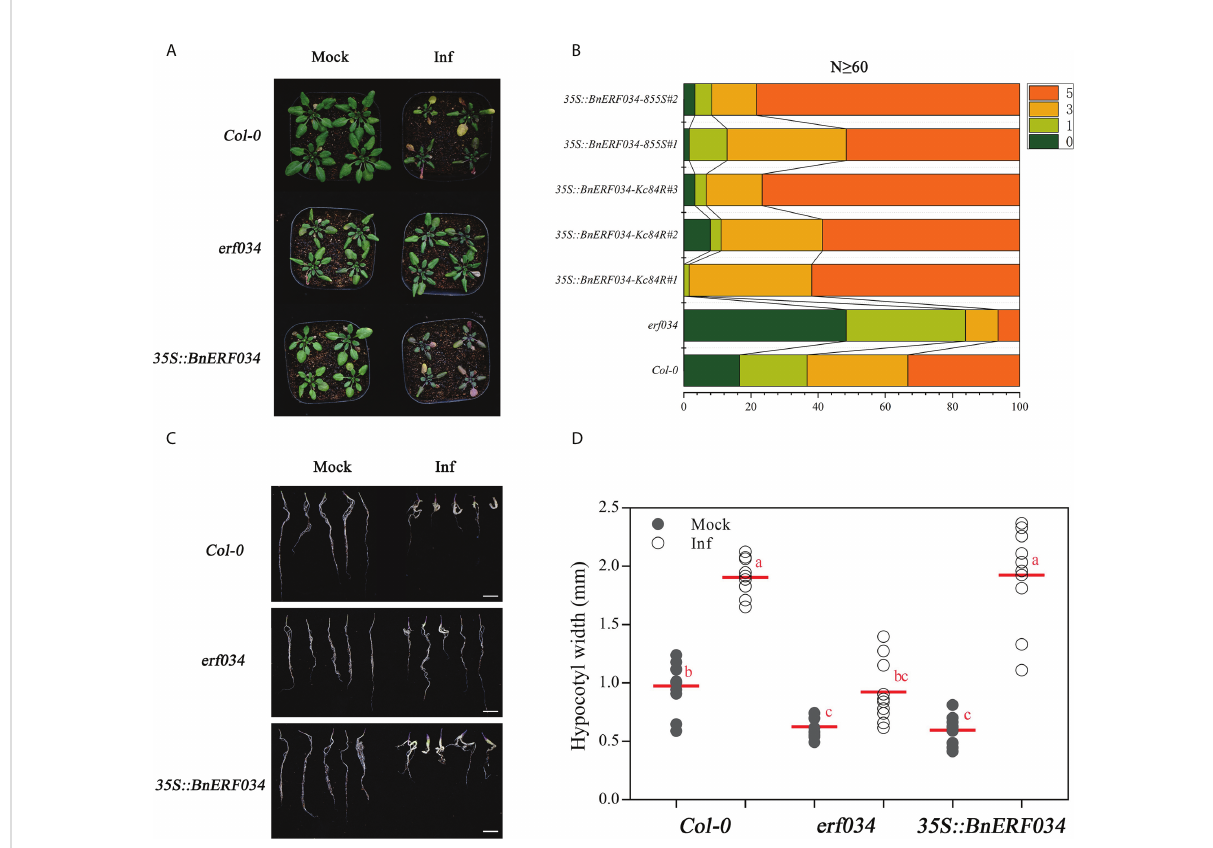
FIGURE 9 BnERF034 enhanced the severity of clubroot disease in A . thaliana . (A) Above-ground phenotype of A. thaliana Col-0, erf034 , and transgenic lines of BnERF034 at 21 dpi. (B) Results of disease survey, 0-5 indicates disease grade. (C) Root phenotypes of A . thaliana materials at 28 dpi, scale bars represent 2 cm. (D) Hypocotyl width of different A . thaliana materials at 28 dpi in sterile water-inoculated (Mock) and P. brassicae - inoculated (Inf). Scatter plots present individual hypocotyl width measurements (10 replicates for each treatment), calculated means and SEs. Different letters indicate signi fi cant differences between means (Tamhane ’ s test, p <